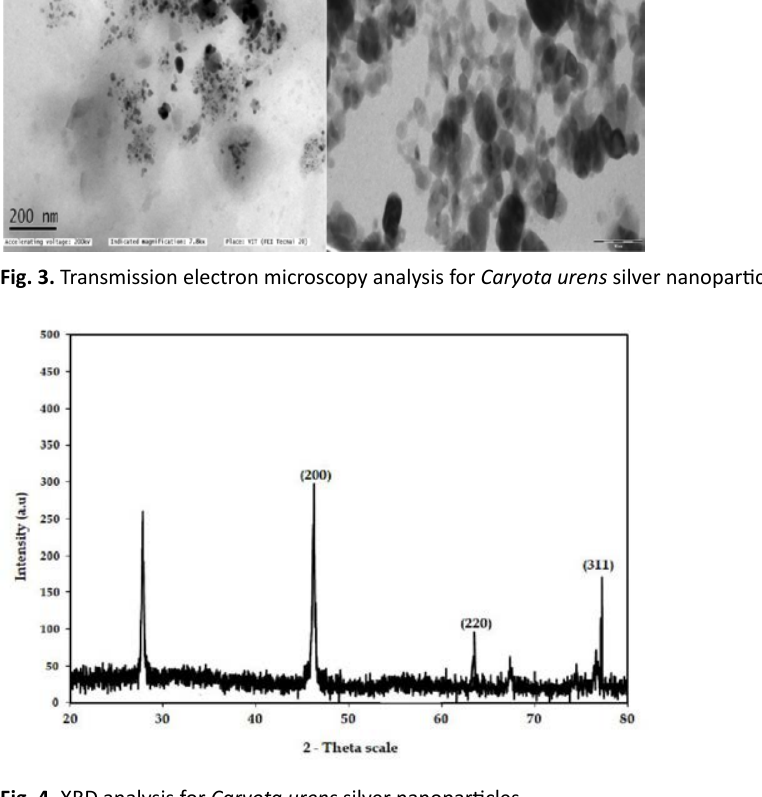
Fig. 4. XRD analysis for Caryota urens silver nanoparticles